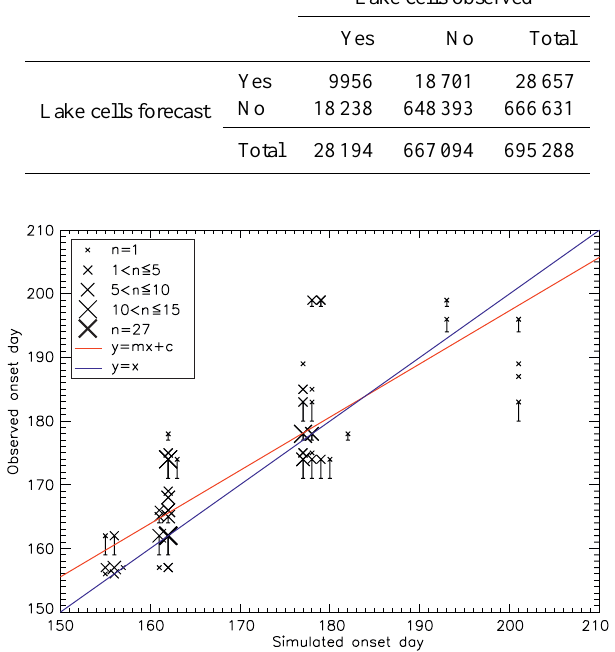
Fig. 4. Correlation between simulated and observed onset day for 159 supraglacial lakes. Vertical error bars indicate uncertainty in observed onset day due to non-uniform temporal sampling, size and weight of symbol indicate number of points, n, with indicated value. Line of best fit is shown in red and a 1 : 1 correlation is shown in blue.